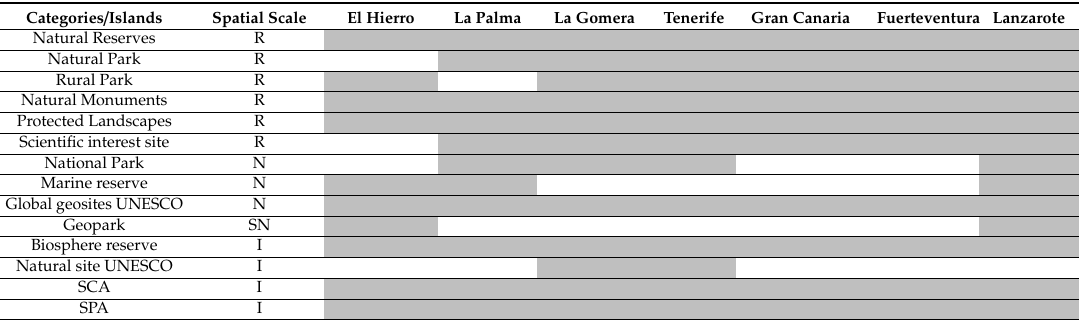
Table 1. Di ff erent protection categories and management of volcanoes of Canary Islands. R = regional, N = national, I =